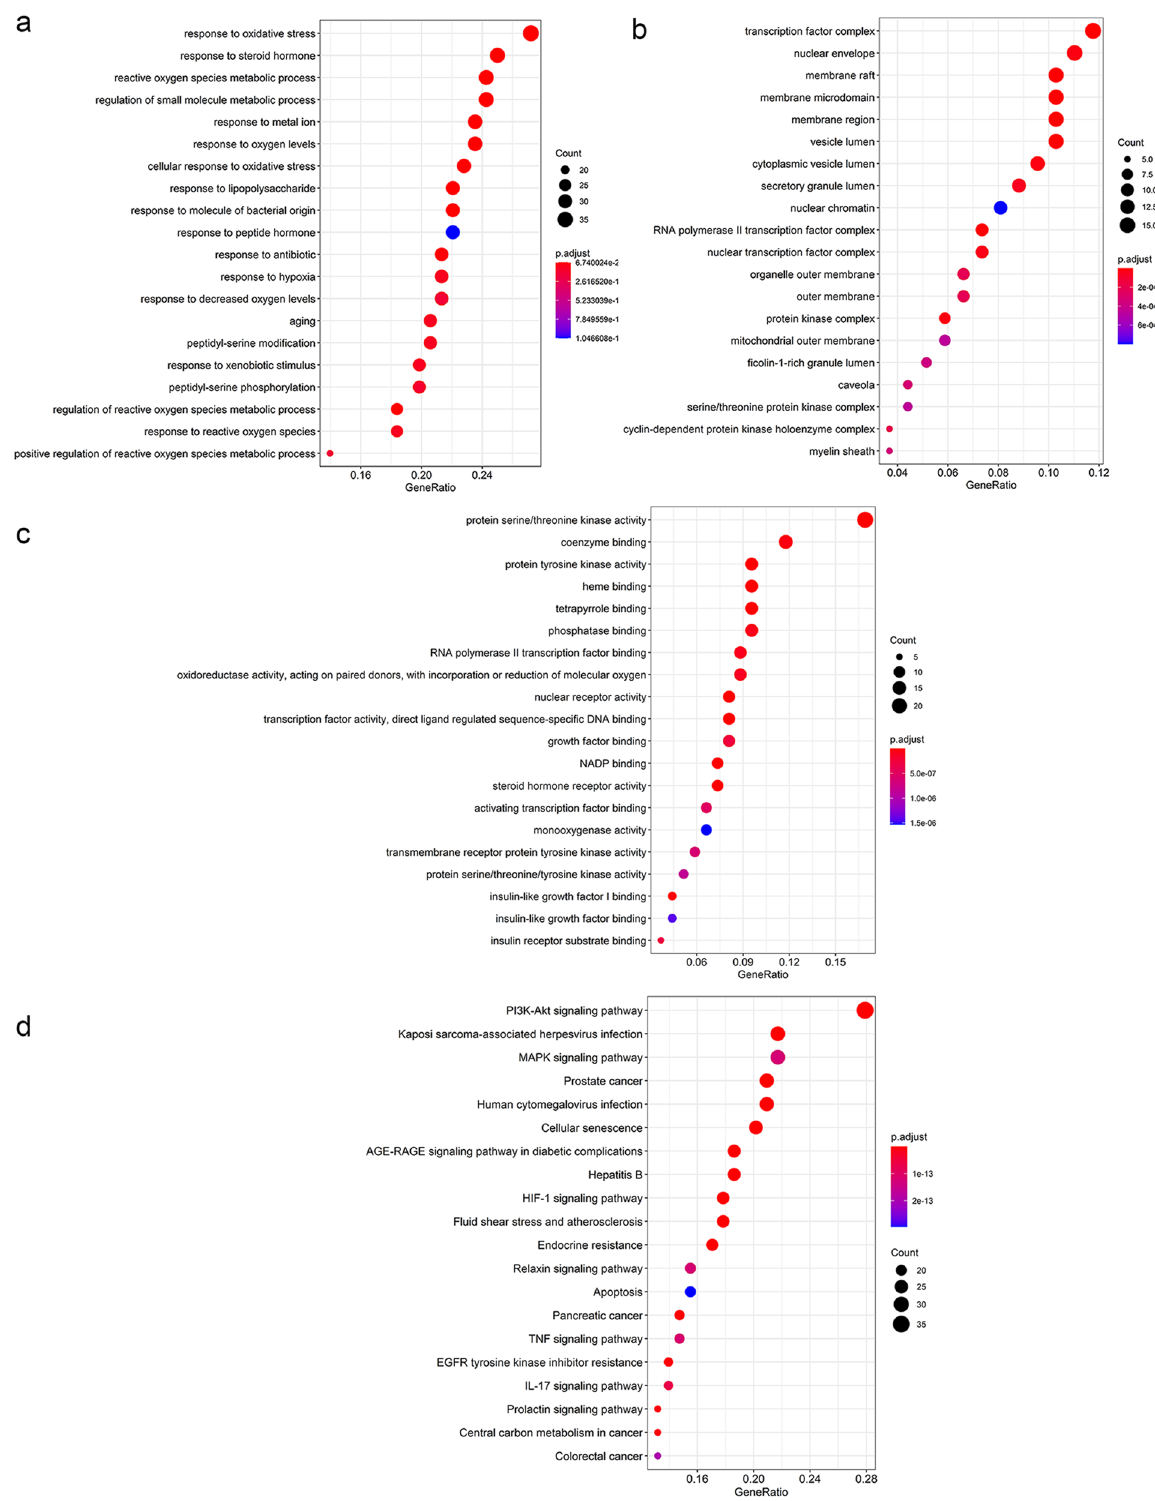
Figure 4. GO and KEGG pathway enrichment analyses of MOLBCH-OA PPI Network (p-value ≤ 0.05). ( a ) The top 20 biological processes. ( b ) The top 20 cellular components. ( c ) The top 20 molecular functions. ( d ) The top 20 KEGG pathways. The color scales indicate the different thresholds for the p-values, and the sizes of the dots represent the number of genes corresponding to each